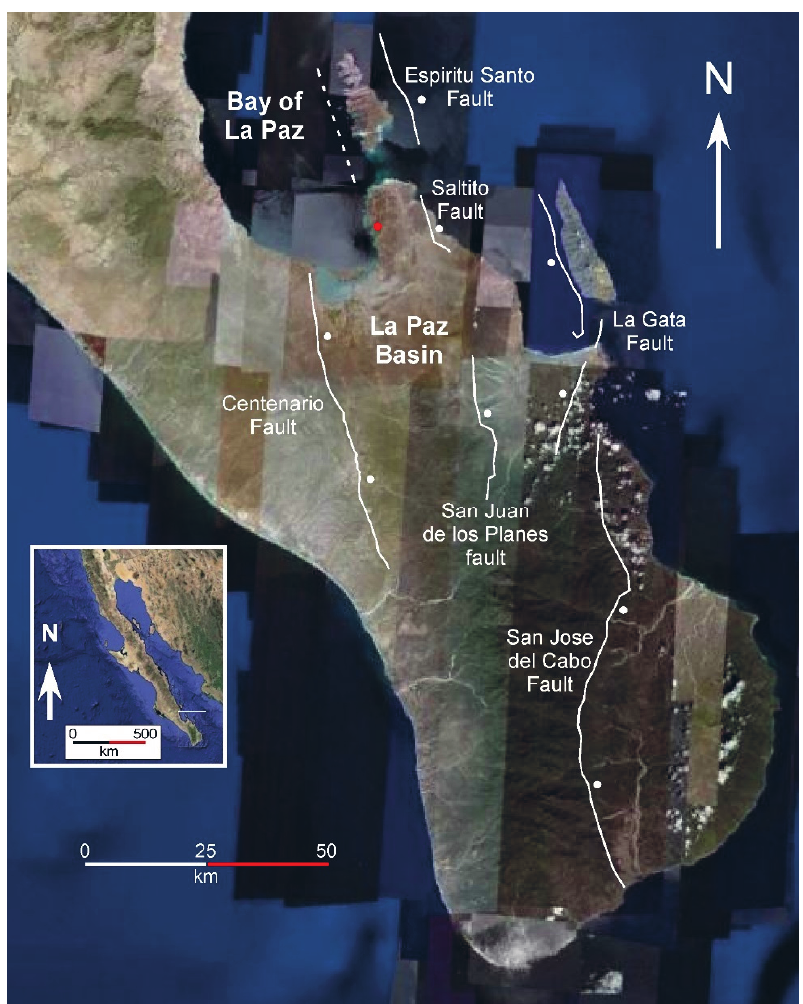
Figure 1. Location of study site. Major faults on the southern section of the Baja California peninsula, as described by Coyan and others [17], are displayed on Google Earth imagery, with dots marking the downthrown blocks. The dashed line represents an unnamed buried fault inferred by previous studies [21,22]. The red dot marks our study site. Inset displays the location of the Baja California Peninsula in relation to the Pacific coast of